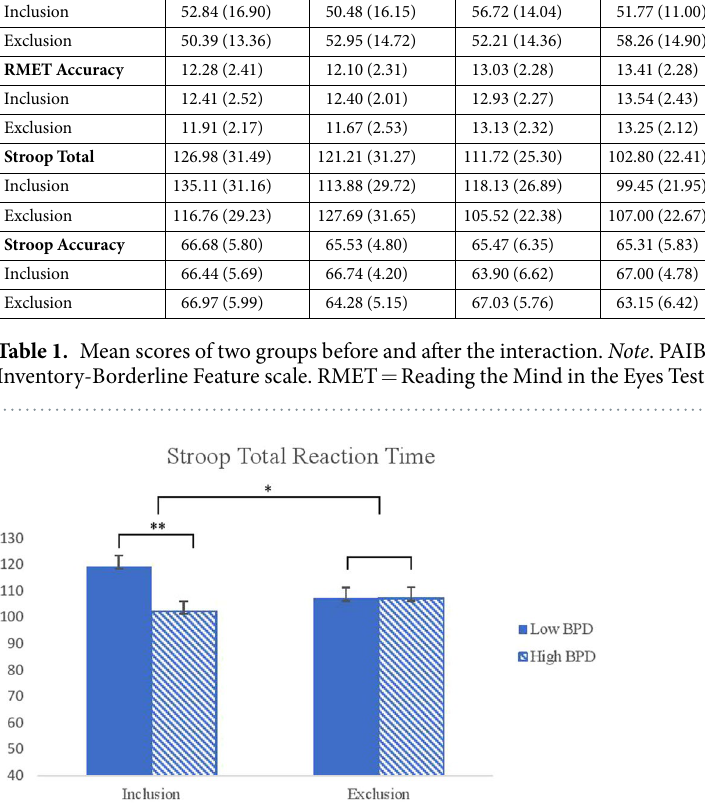
Figure 2. Interaction effects between conditions and the level of BPD features on the total reaction time of the emotional Stroop task. Note . BPD = Borderline Personality Disorder. * p < 0.05 , ** P < 0.01